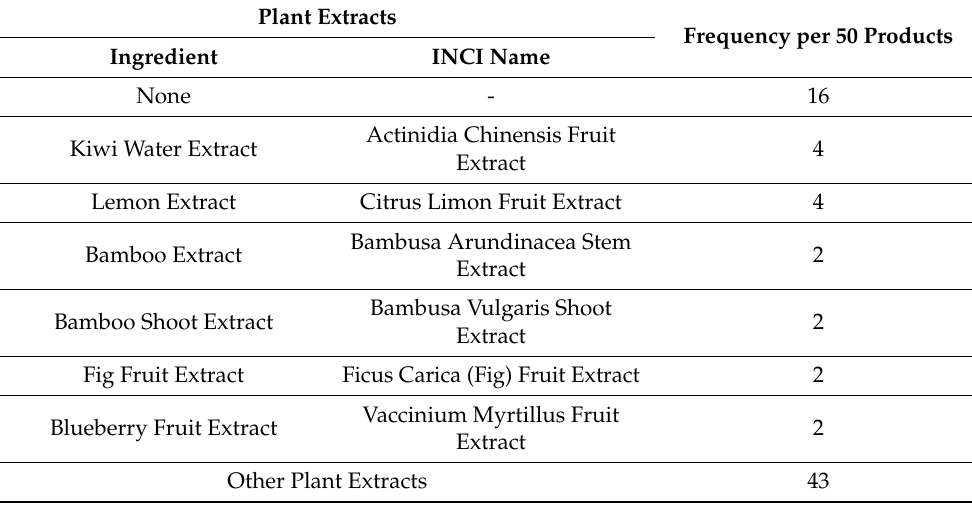
Table 1. Frequency of plant extracts in the analyzed abrasive cosmetic